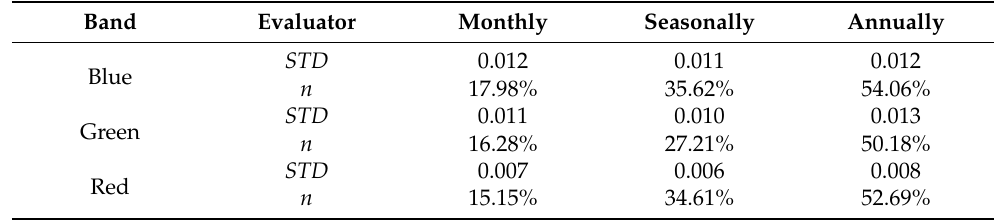
Table 2. The STD and n of the R wt in visible bands after monthly, seasonal and annual correction,